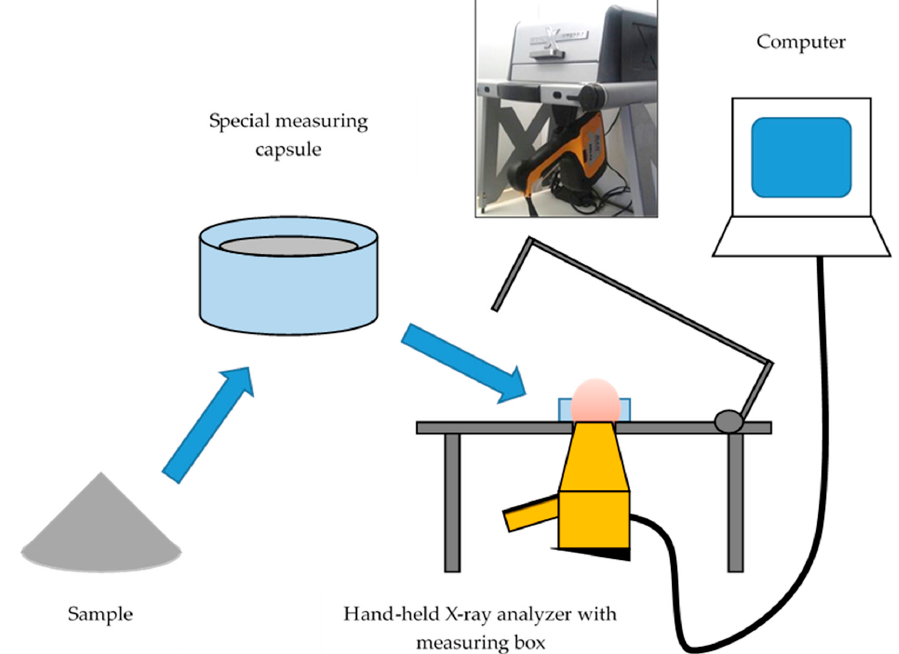
Figure 1. The schematic diagram of the measurement of the detection of elements using a simple handheld X-ray analyzer Innov-X DELTA (Innov-X Systems, INC., Woburn, MA, handheld X-ray analyzer Innov-X DELTA (Innov-X Systems, INC., Woburn, MA, USA).